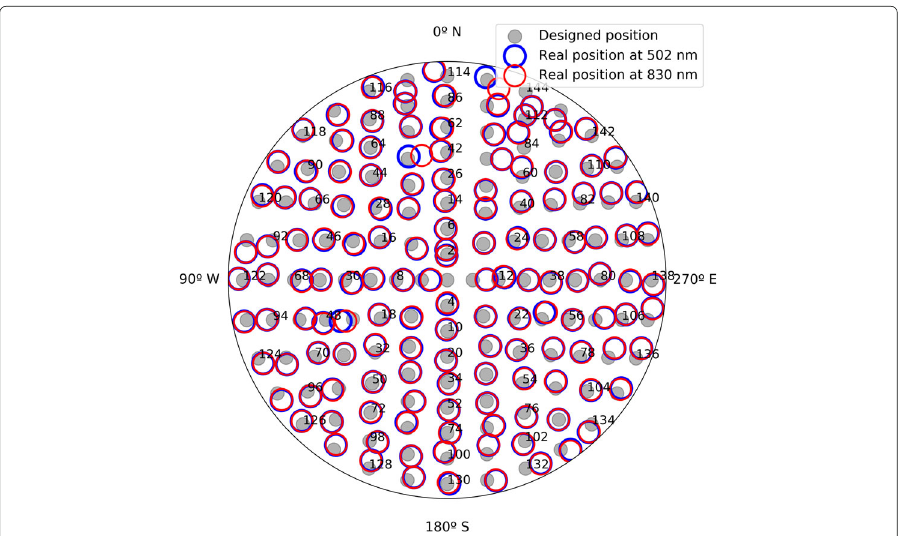
Fig. 14 Expected and actual FOV positions of the AMUDIS input optics. The red and blue circles represent the FOVs of the optical fibres at 502 nm and 830 nm respectively. The optical fibres are represented by grey